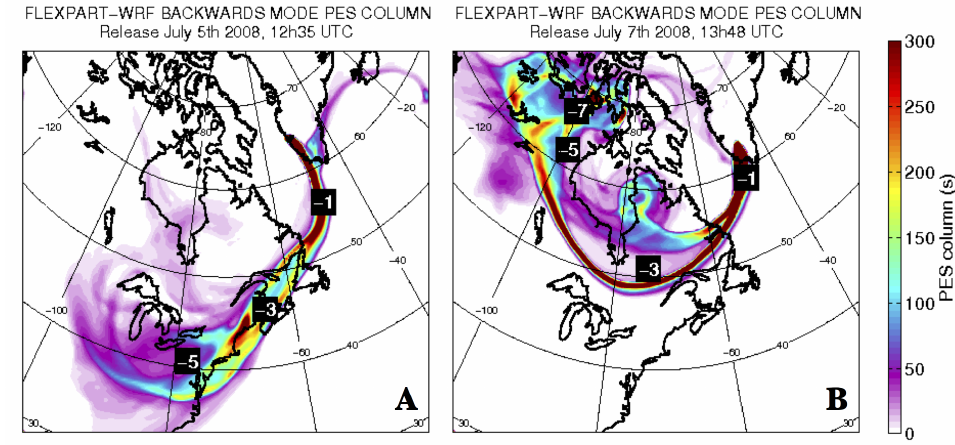
Fig. 9. FLEXPART-WRF potential emissions sensitivities (PES) for the second plume sampled by the ATR-42 aircraft on 5 July 2008 at 12:30UTC (a) and the first plume sampled on 7 July 2008 at 13:45UTC (b) , the location of the average emission sensitivity for each day prior to the release time are also indicated in white. The emissions sensitivities show clearly that the plumes have different origins; the plume sampled on 5 July is anthropogenic in origin, while the first plume on 7 July originates from the region where boreal forest fires were burning in June–July 2008.